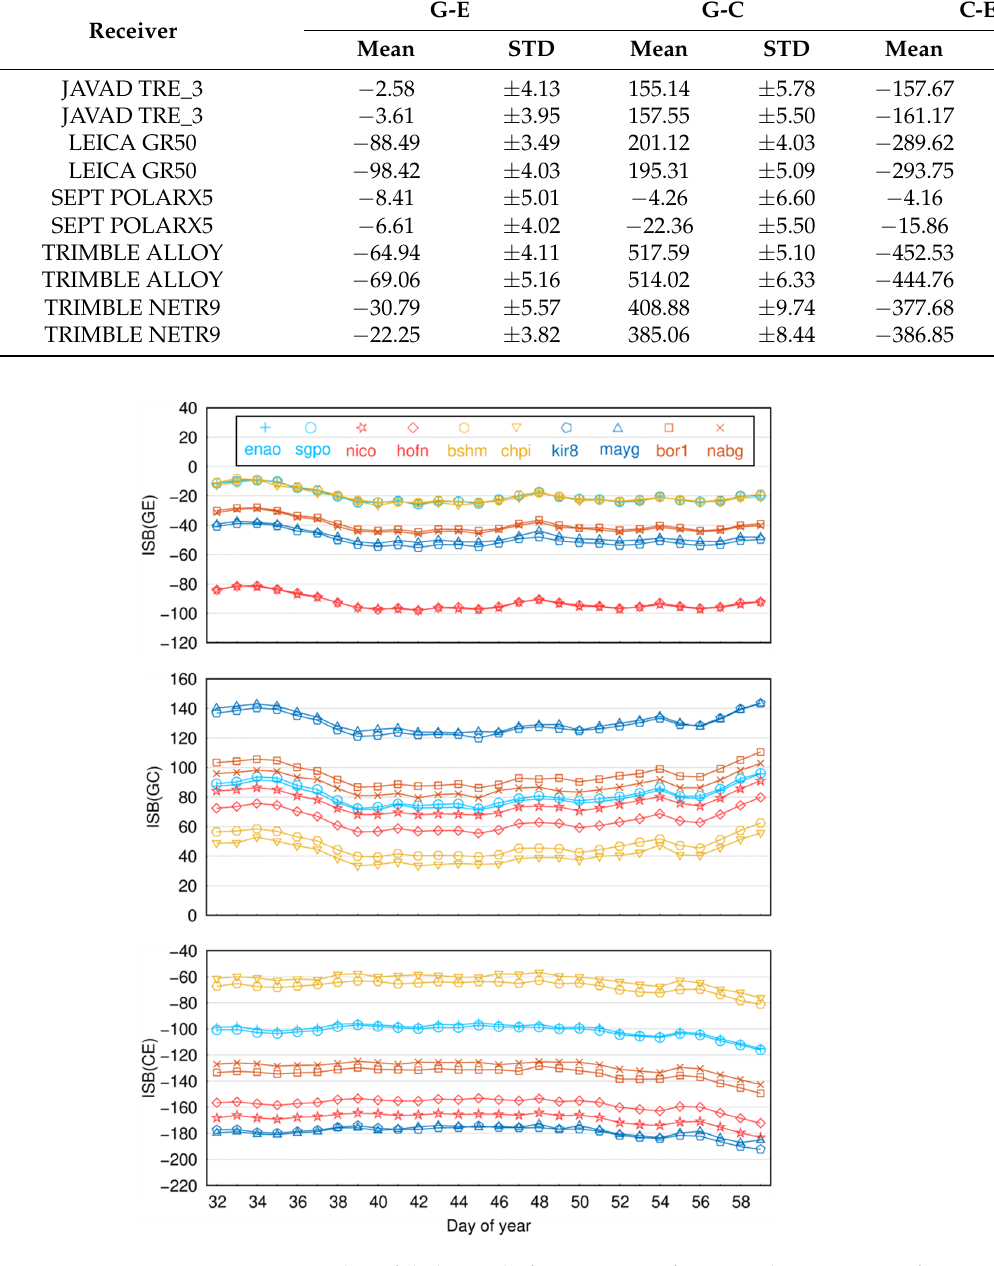
Figure 19. Average value of daily single-frequency ISB for 10 tracking stations of 5